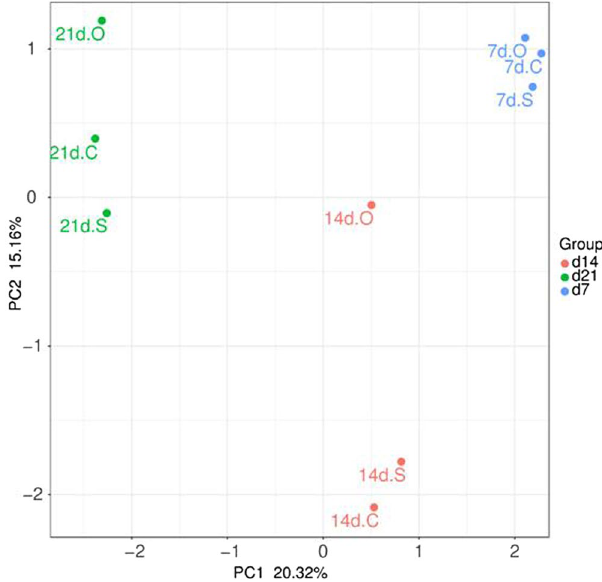
Figure 6. PCoA of microbial community